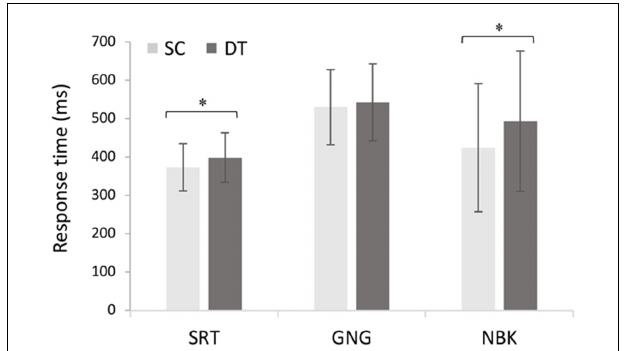
FIGURE 5 | Mean changes in response time across single cognitive (SC) and dual-tasks (DT) with increasing cognitive demand ( N = 19, F (2,36) = 4.1, p = 0.026, η 2 p = 0.18). Error bars represent standard deviation and ( ∗ ) denotes a significant difference ( p <